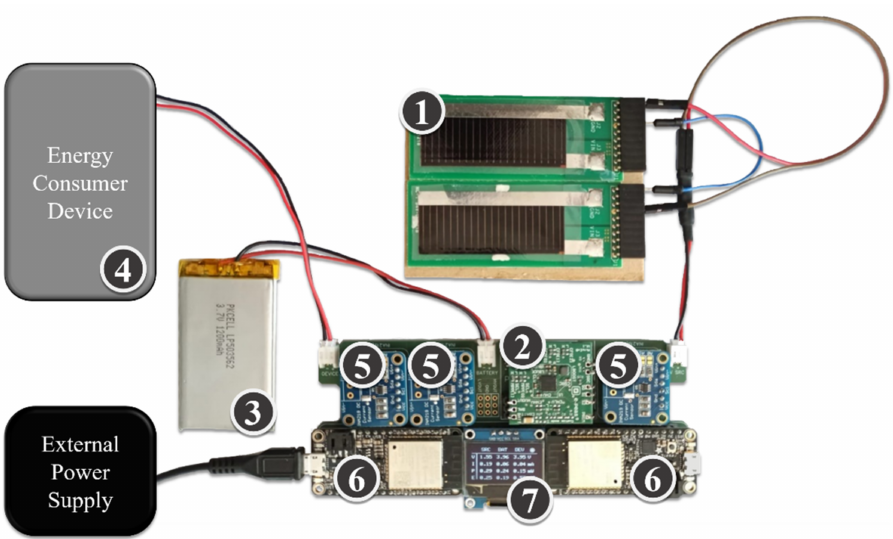
Figure 3. Picture of the experimental setup: (1) two GaAs solar cells from Alta Devices Inc.; (2) Power Management Integrated Circuit (PMIC) from e-PEAS; (3) Lithium-polymer battery of 4.4 Wh; (4) energy-consuming devices; (5) INA219 power measurement integrated circuits from Texas Instru- ments; (6) ESP32 microcontrollers, in charge of gathering and storing data, integrated on HUZZAH Feather boards made by Adafruit; (7) OLED display to show system operating